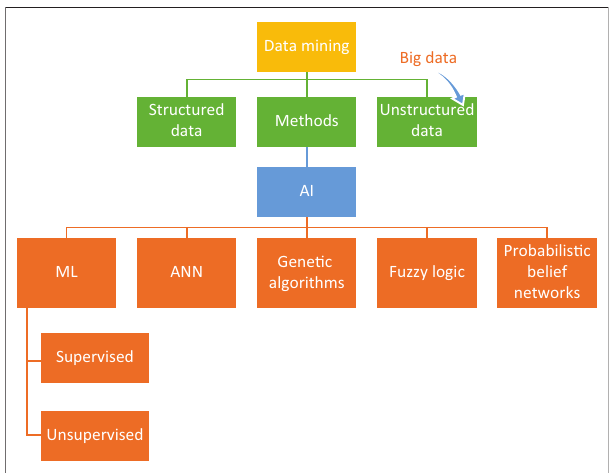
FIGURE 1: Data science.